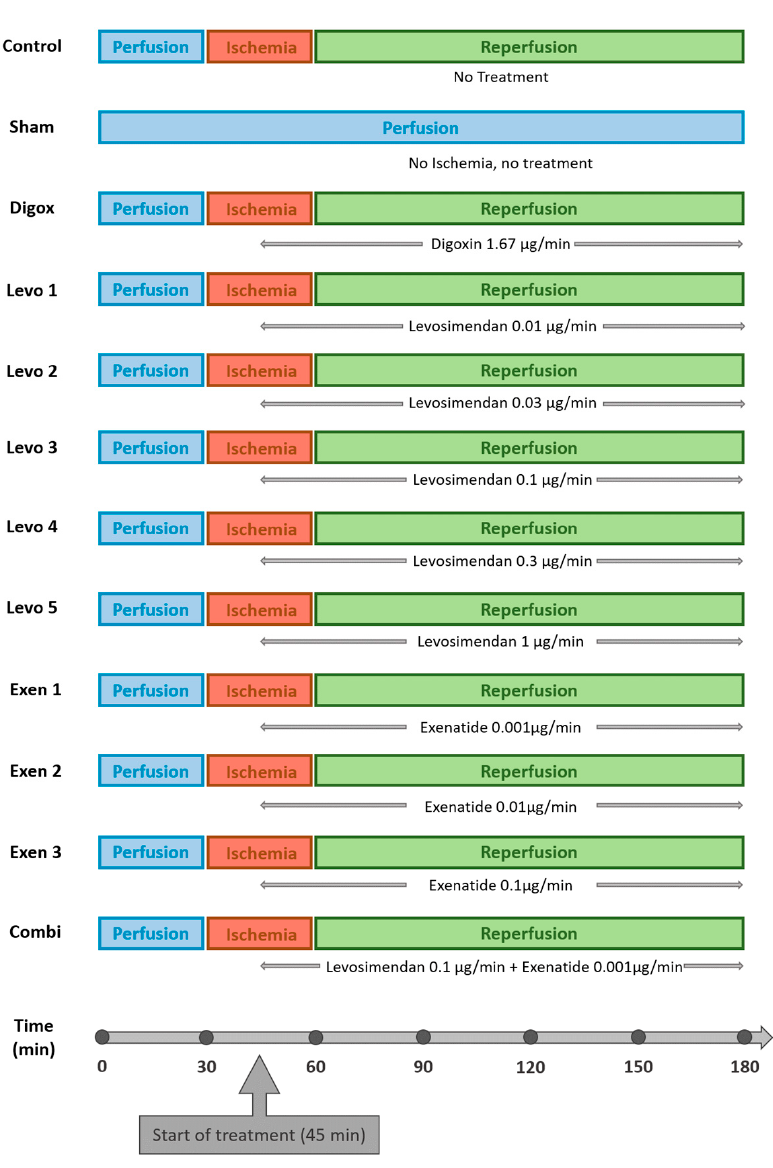
Figure 1. Schematic demonstration of the experimental protocol showing the groups and the dura- tions of the three phases of the experiment (perfusion, ischemia and reperfusion). The application of the treatment started at the middle of the ischemia phase and was continued until the end of the reperfusion phase.